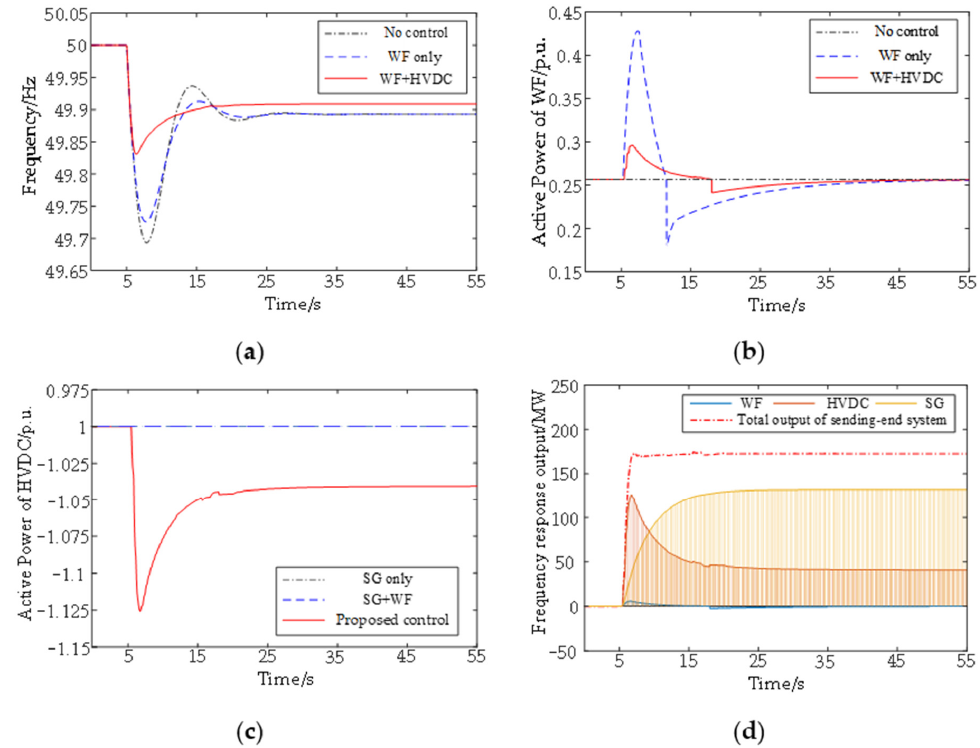
Figure 15 Figure 15. Simulation results under low wind power permeability and low wind speed condi- tion. ( a ) Sending-end system frequency, ( b ) active power of WF, and ( c ) active power of HVDC, ( d ) frequency response output of sending-end